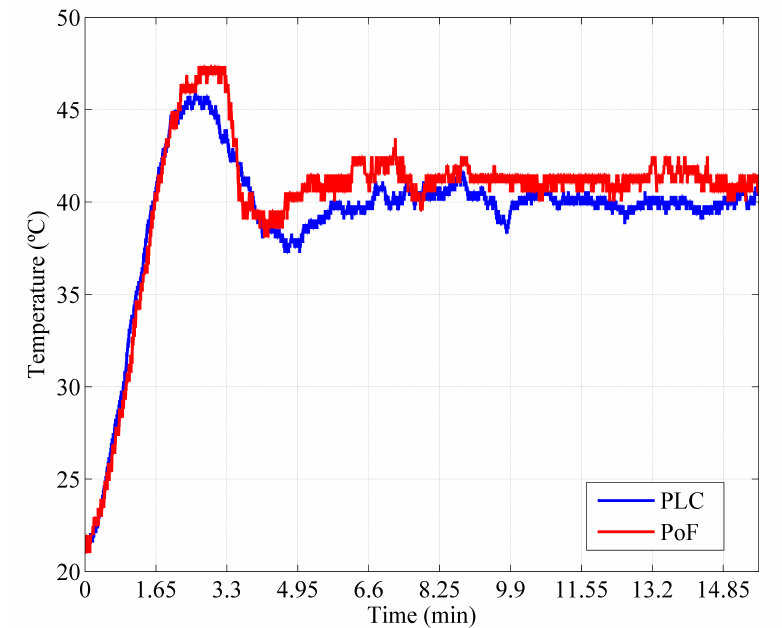
Figure 8. Temperature comparison between the PoF-based approach and the conventional indus- trial PLC. The temperature measurements were acquired from the optically-powered TX node 1 (first